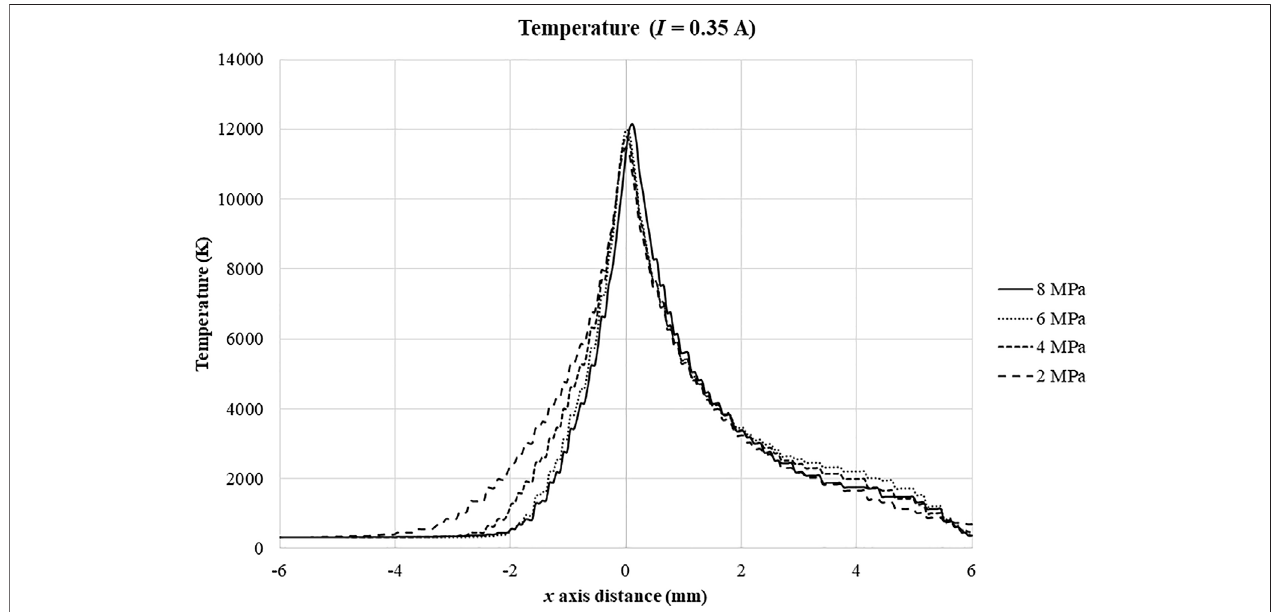
FIGURE 3 | Temperature in the x axis direction at the center of the inter-electrode gap ( t (cid:2) 50 ms, I (cid:2) 0.35 A).